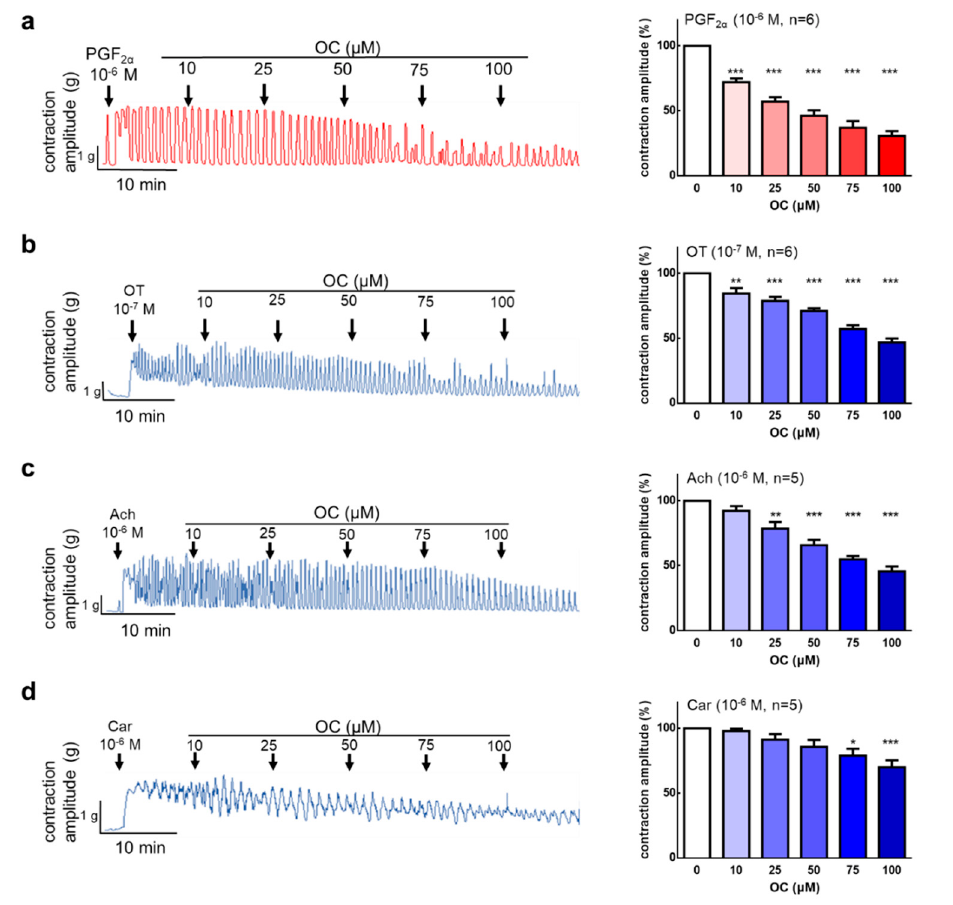
Figure 1. Effects of oleocanthal on prostaglandin F2 α (PGF2 α ), oxytocin (OT), acetylcholine (Ach), and carbachol (Car)-induced uterine contraction in an ex vivo study. Oleocanthal (OC) (10–100 μ M) was administered after ( a ) PGF2 α -induced contractions, ( b ) OT-induced contractions, ( c ) Ach-induced contractions, and ( d ) Car-induced contractions. The effect of OC on the mean peak amplitude was calculated. Data are presented as the mean ± standard error of mean (SEM) ( n = 3–6). * p < 0.05, ** p < 0.01, *** p < 0.001 versus 0 μ M.